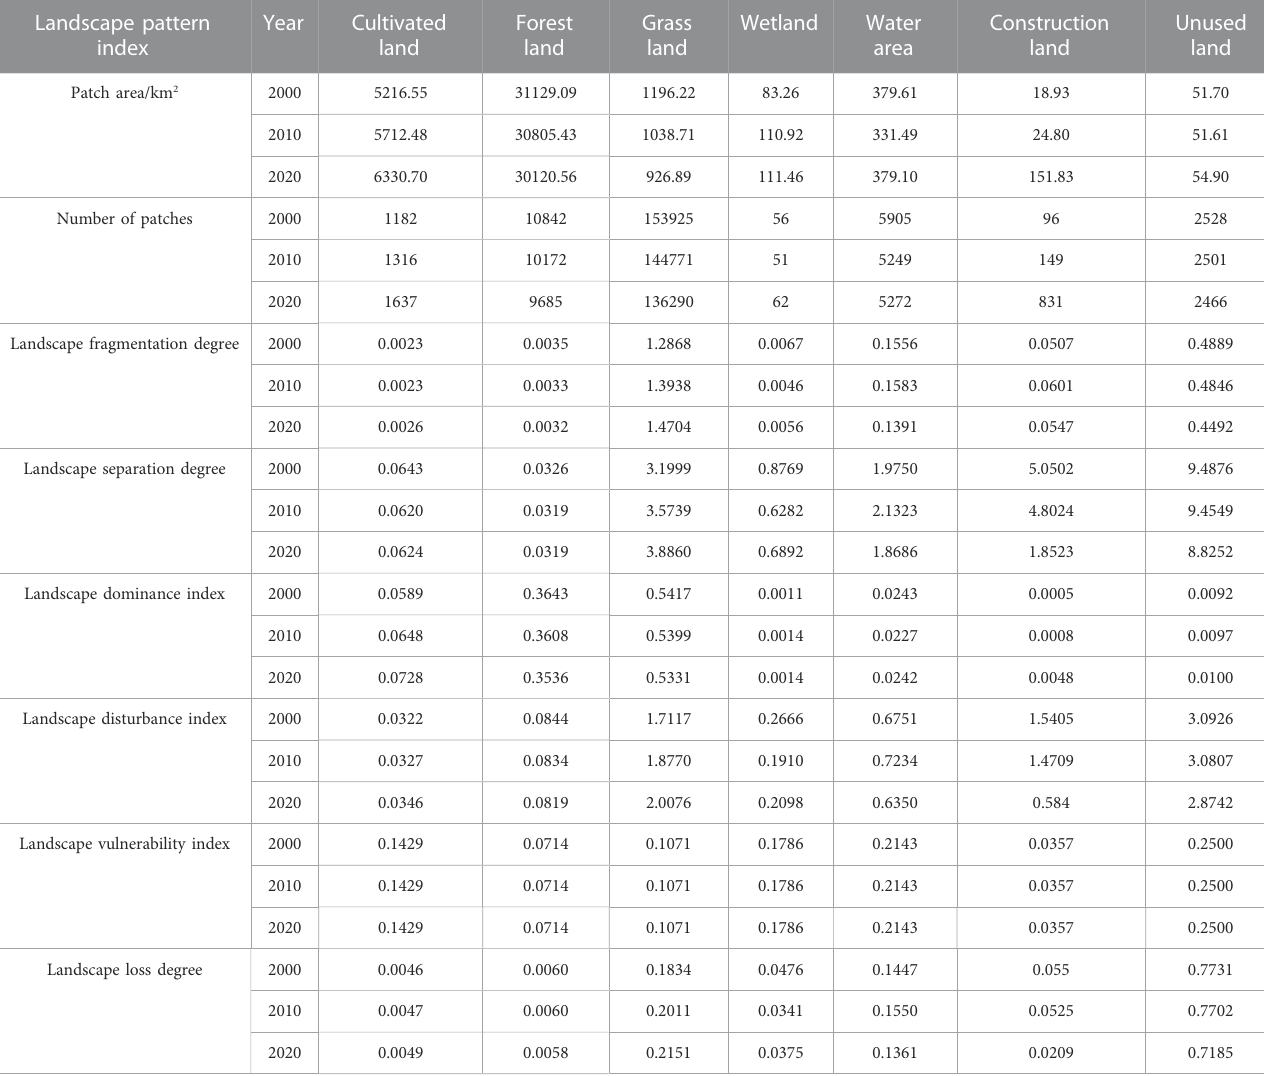
TABLE 3 Changes in landscape pattern index in Savan District from 2000 to 2020. Landscape pattern